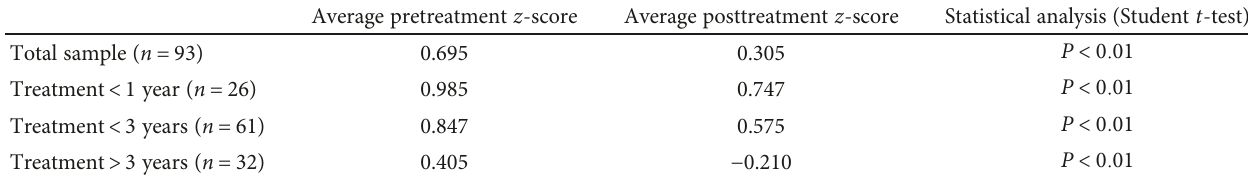
Table 2: Comparison between pre- and posttreatment BMI z